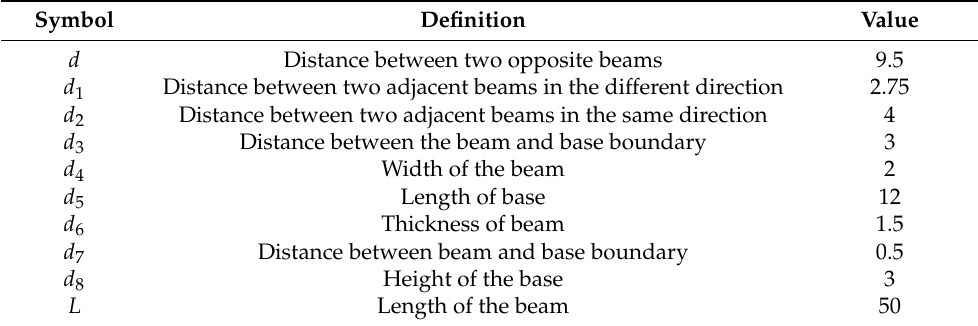
Table 2. Dimensions of the 3D U-shaped electrothermal actuator (unit of length: